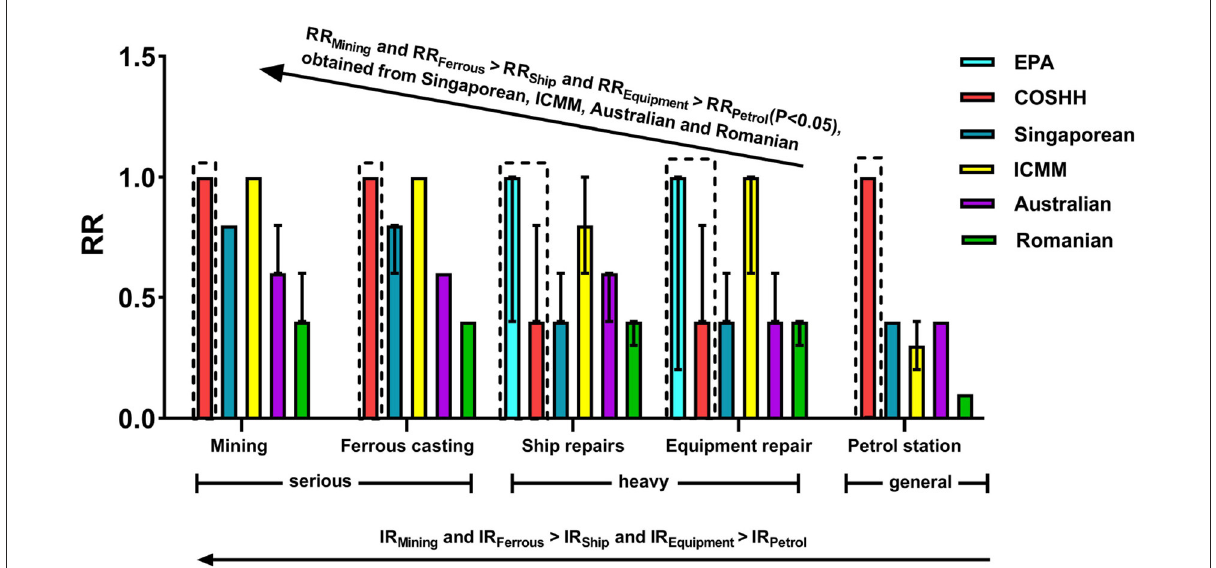
FIGURE1 Quantitative comparison of RRs obtained for the five industries using the six models [median (interquartile spacing)]. The orders of RRs obtained using the Singaporean, ICMM, Australian, and Romanian models in the five industries were consistent with the orders of the three inherent risk levels in those industries. Only the Romanian model could distinguished the RRs of the five industries.